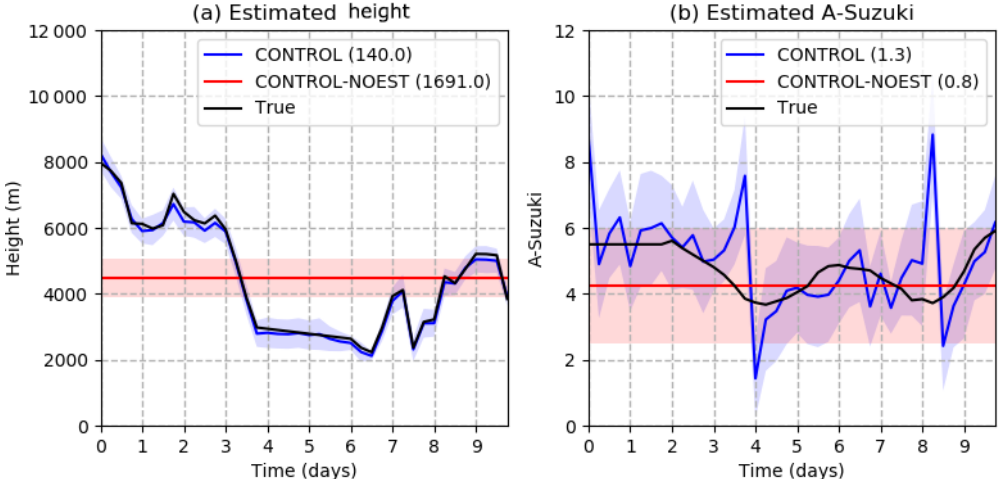
Figure 8. Optimized parameters as a function of time in the CONTROL (blue line) and CONTROL-NOEST (red line) experiments. The shading surrounding the estimated values represents ± 1 standard deviation; (a) h parameter and (b) A Suzuki parameter. The black line indicates the value of the parameters in the true